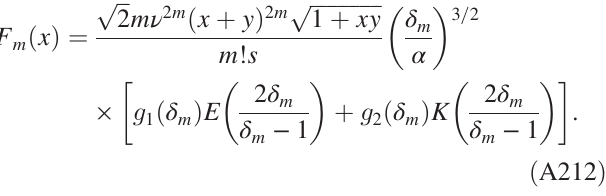
ffiffiffiffiffiffiffiffiffiffiffiffiffi p 1 þ xy